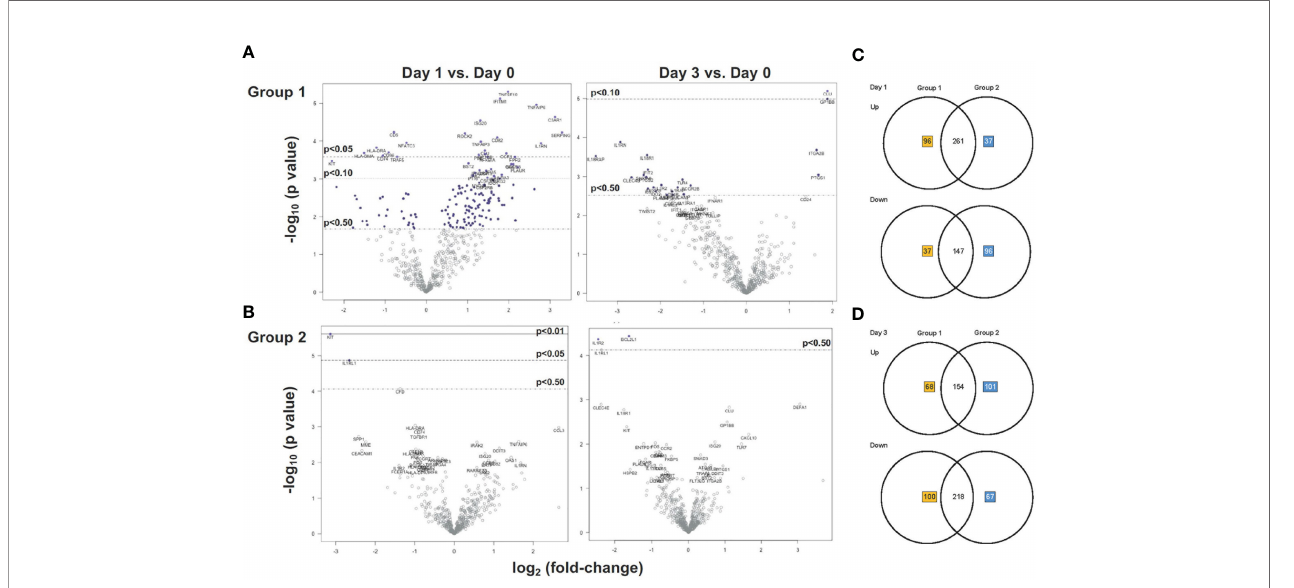
FIGURE 4 | Gene expression analysis of Group 1 and Group 2 prior and post vaccination. (A, B) Volcano plots displaying the log 2 change in mRNA expression on D1 (left plots) and D3 (right plots) versus D0 in Group 1 (A) and Group 2 (B) . The x-axis lists the log 2 fold-change and the y-axis the corresponding -log 10 p-value for each gene (each gene is represented by a circle). Dashed horizontal lines indicate the adjusted p-value thresholds of p < 0.05 and p < 0.1 determined by Benjamini- Yekutieli procedure. Genes highlighted by red boxes indicate representative examples of the identical gene in Group 1 and Group 2 with the same direction (up- or down-regulation) in the change of mRNA expression on day1 (left plots) or day 3 (right plots). (C, D) Venn diagrams depicting the number of unique and shared up- regulated and downregulated genes at D1 (A) and D3 (B) after vaccination in Groups 1 and 2. Unique genes in Group 1 or Group 2 are indicated by orange or blue numbers respectively, the number of shared genes is listed in